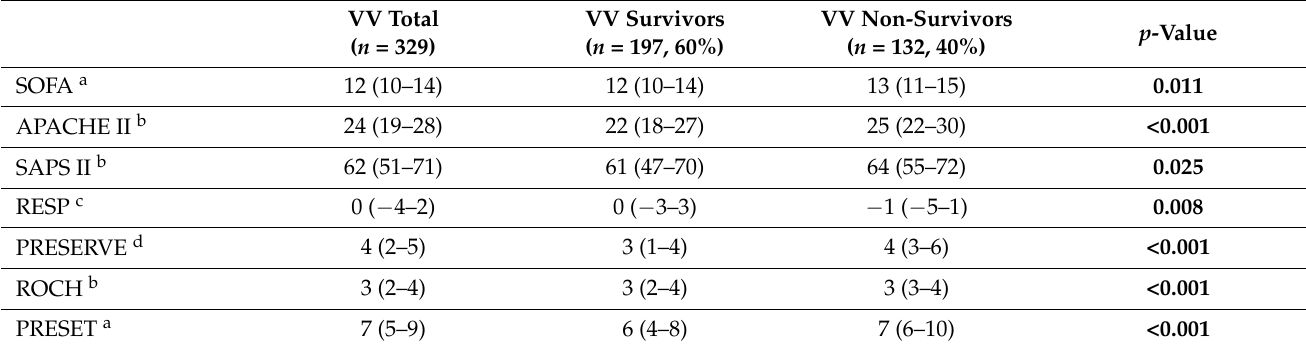
Table 4. Scoring results in patients on ECMO before implantation according to survival (veno-venous ECMO